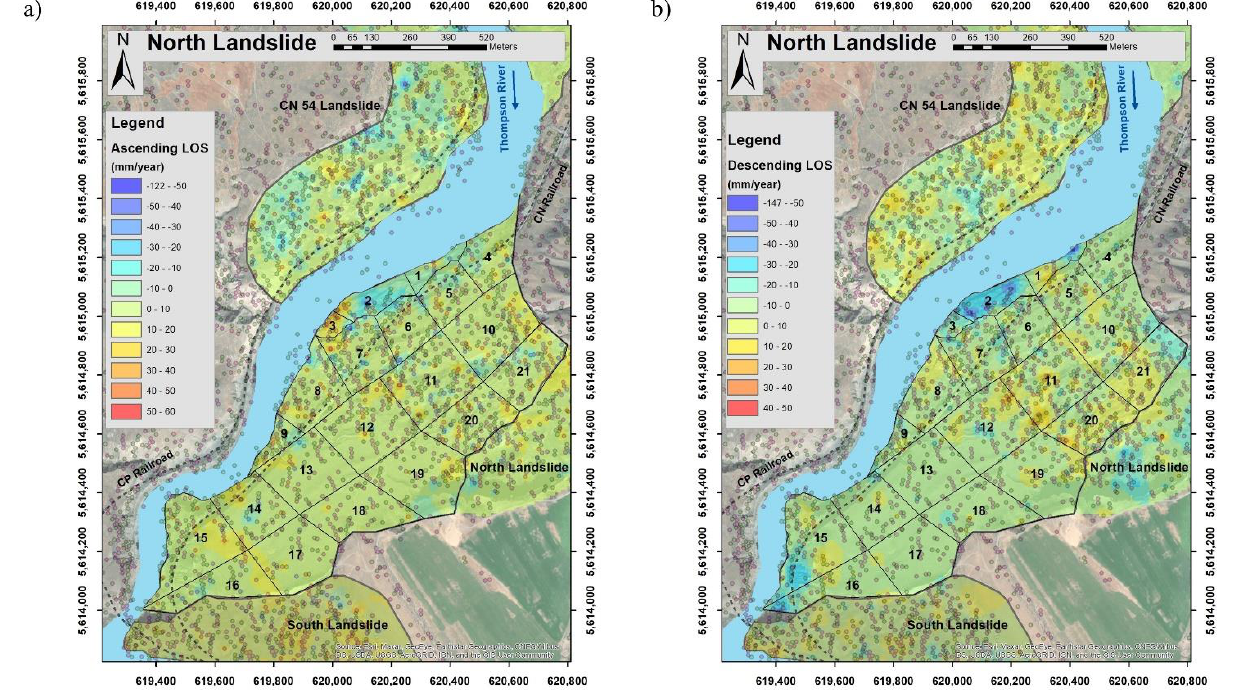
Figure 8. The cumulative LOS changes at the end of the selected timeline for the North landslide for ( a ) Sentinel ascending and ( b ) Sentinel descending orbits. In all sectors except sector 3, LOS displacements are in the range of ±10 mm (ascend- ing) and up to 25 mm at the end of the time period. The cumulative LOS displacements are ±10 mm (descending) for all sectors except sectors 1, 2, and 3. The maximum displace- ment occurred in sector 1 (approximately 50 mm in 2 years).